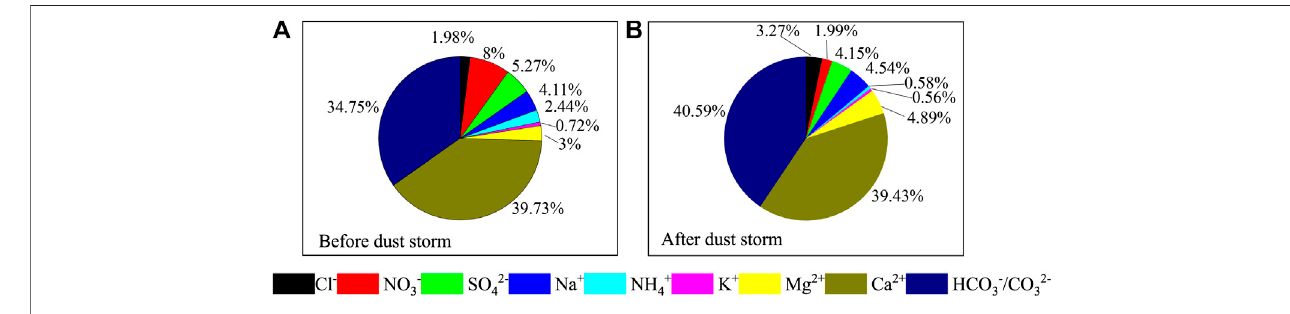
FIGURE 3 | (A) Before and (B) after dust storms.